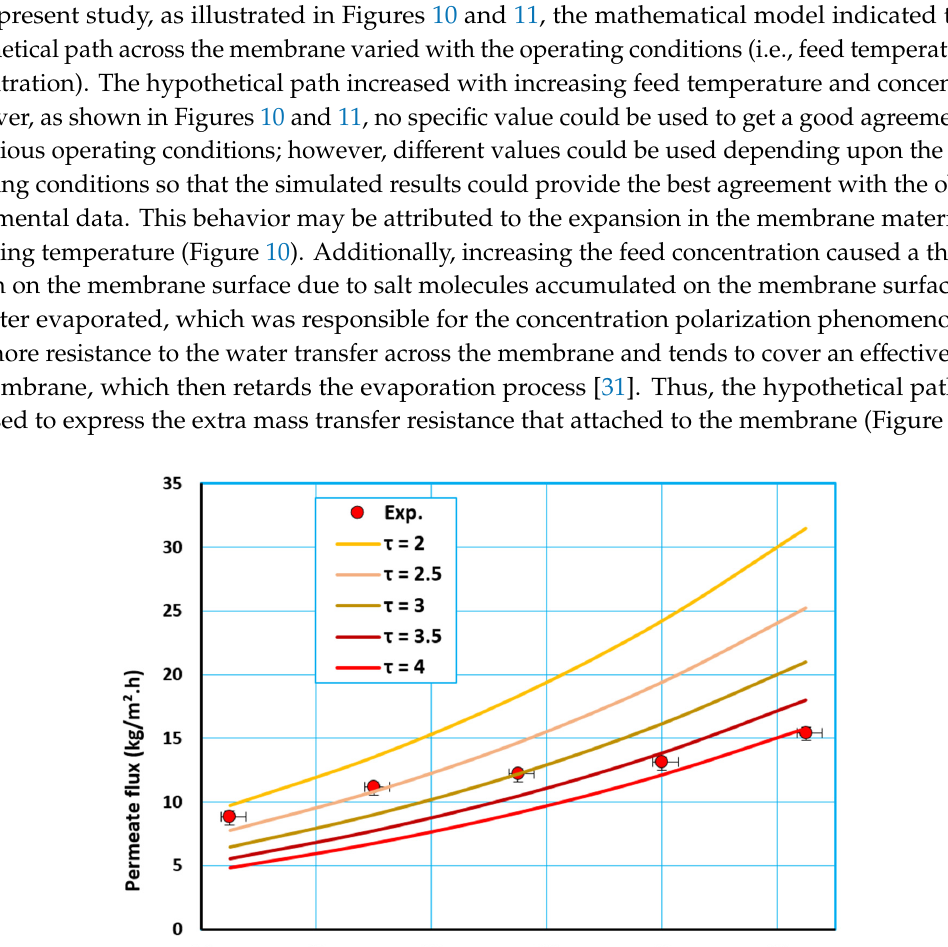
Figure 11. Effect of the feed concentration on the permeate fluxes at various tortuosity levels predicted by the model with the experimental data at a feed temperature of 60 °C and a feed flow rate of 1.07 L/min. Figures 12 and 13 show the effect of the feed temperature and concentration on the experimental and theoretical fluxes at various membrane hypothetical paths (tortuosity). There was a significant enhancement in the simulated results compared with the experimental data, and a good agreement was obtained, as shown in the aforementioned figures.